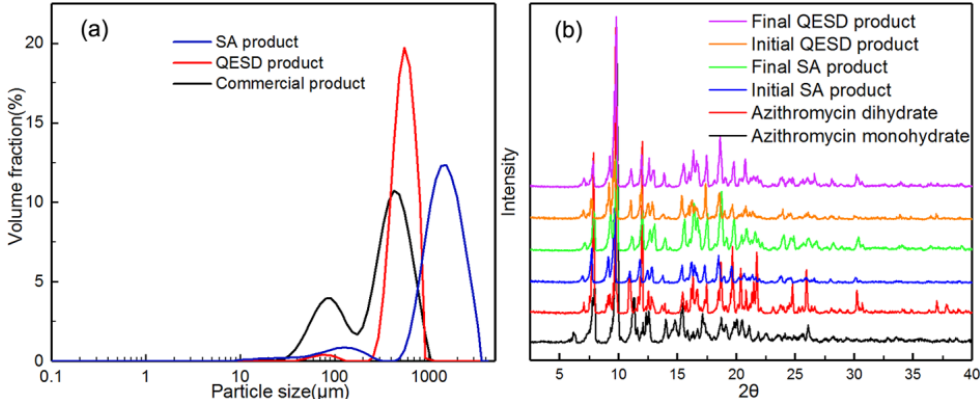
Figure 3. ( a ) Particle size distribution of the commercial and spherical products; ( b ) PXRD di ff raction patterns of the crystallization